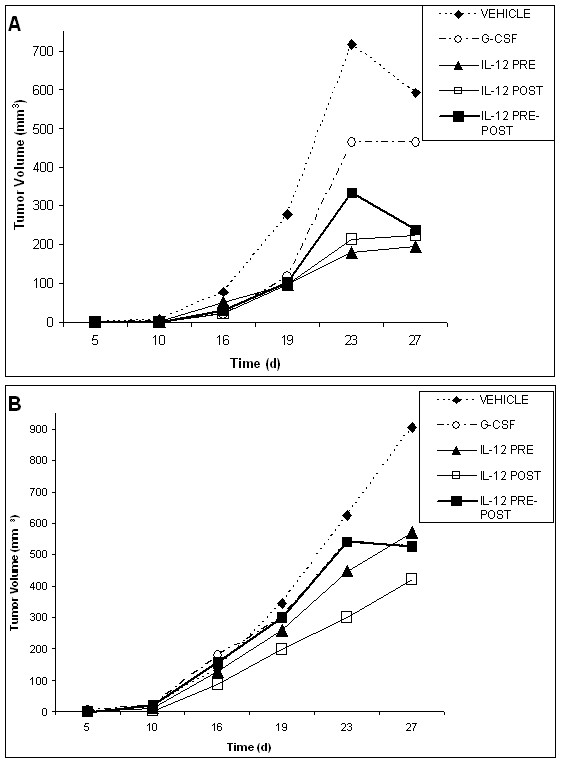
Relative changes in tumor volumes for vehicle, G-CSF, IL-12 pre-only, IL-12 post-only and IL-12 pre-post treatment groups following radiation. Changes in tumor volumes over the course of the experiment are shown for the EL4 lymphoma tumor model (A) and the Lewis Lung cancer tumor model (B). Mice in both tumor models were given 625 rad at day 1. Mice in the EL4 lymphoma tumor model were given a second dose of radiation on day 22 (560 rad), and mice in the Lewis Lung cancer tumor model also were given a second dose of radiation on day 22 (750 rad) following the initial radiation dose. Tumor measurements were made on the days indicated by measuring the tumor diameter and converting this measurement into tumor volume using a spherical volume formula. In the EL4 lymphoma model, all IL-12 treatment groups significantly reduced tumor growth (%T/C < 50%) as compared with the PBS and G-CSF controls at the end point of tumor volume evaluation. In the Lewis lung cancer model, only the IL-12 post-only treatment group gave a significant reduction in tumor growth (%T/C < 50%) at the end point of tumor volume evaluation. The change in the slope of the curve for days 19–23 as compared to days 23–27, which occurs after the second radiation, may indicate a radio-sensitizing effect of the indicated treatments.